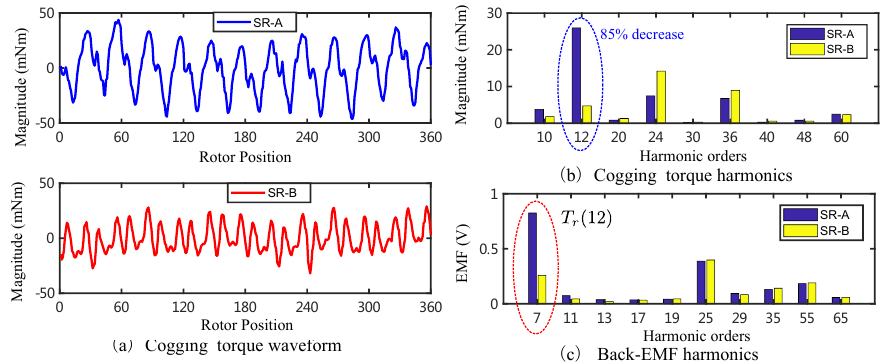
Figure 19. The torque performance and back-EMF of the two